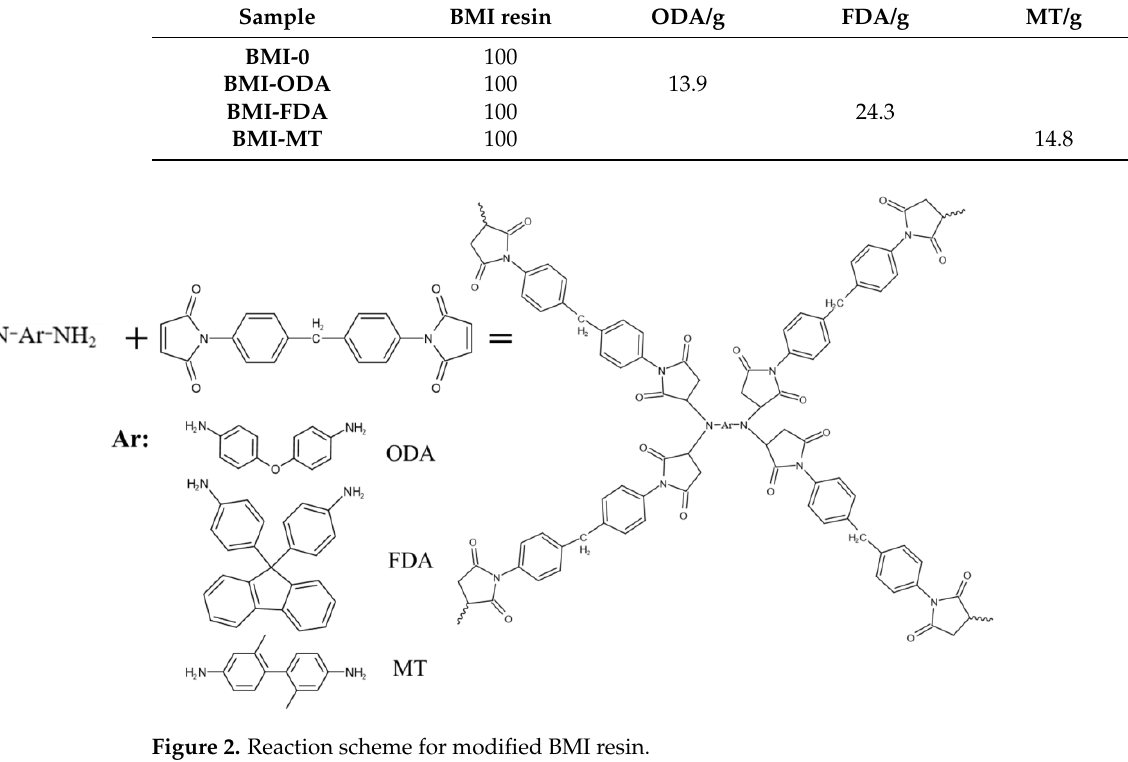
Figure 2. Reaction scheme for modified BMI resin.